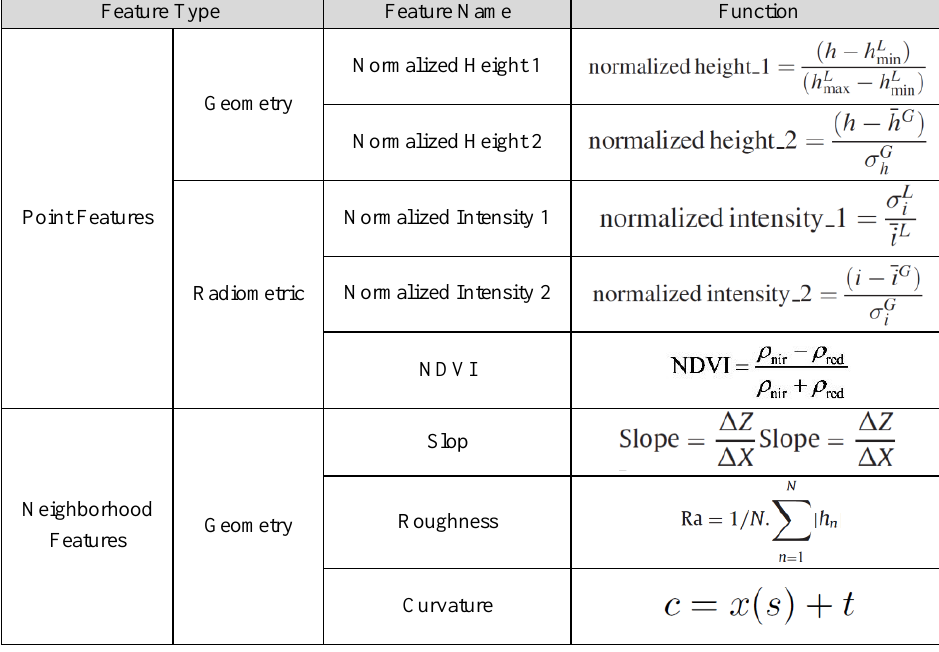
Table 1. the extracted features from point cloud